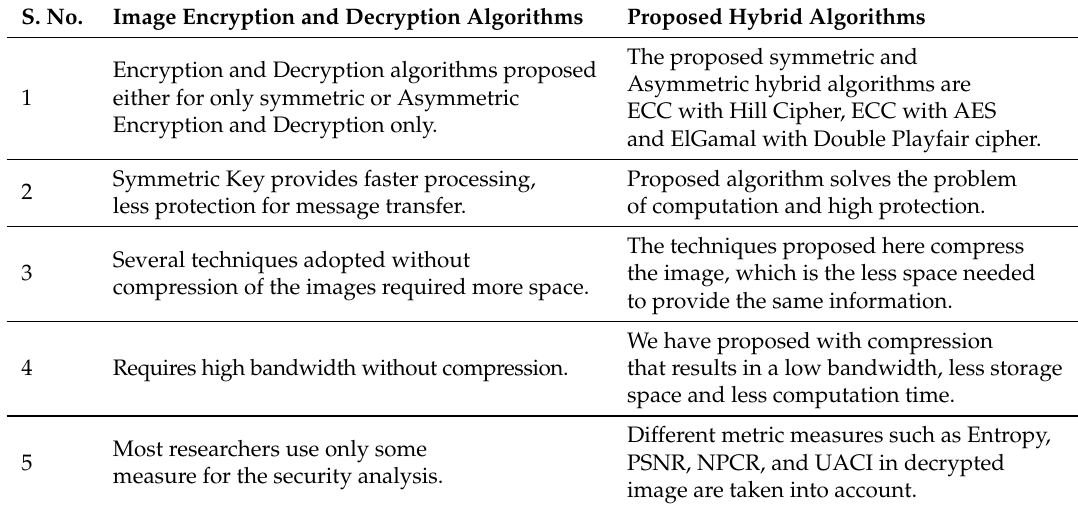
Table 8. Comparative analysis of proposed hybrid